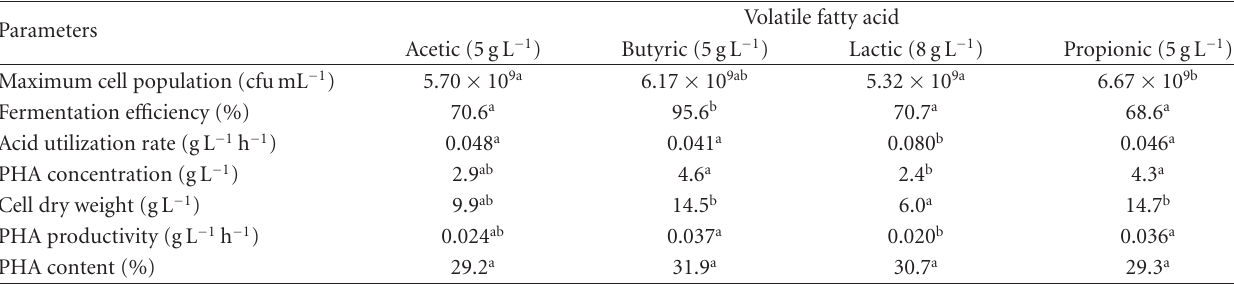
Table 5: Comparison of combined short fatty acid feeding of Ralstonia eutropha in shake